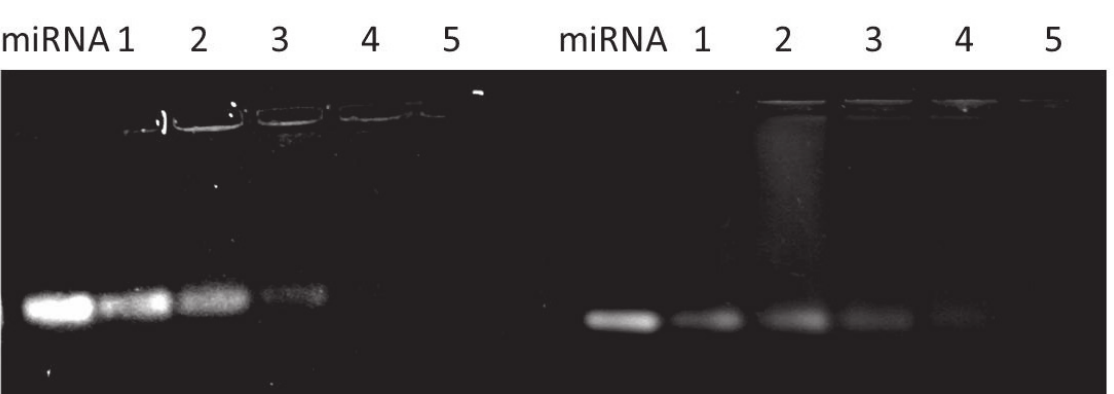
Figure 2: Electrophoresis of PEG-PEI/miR-221 (a) and PEG-PEI/miR-222 (b) formed at various N/P ratios and miR-221/222 dose of 100